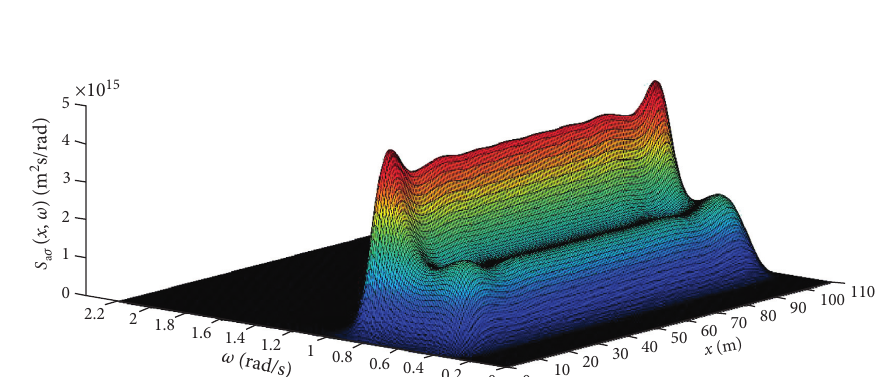
Figure 5: Stress response spectrum caused by the transverse dynamic responses ( H